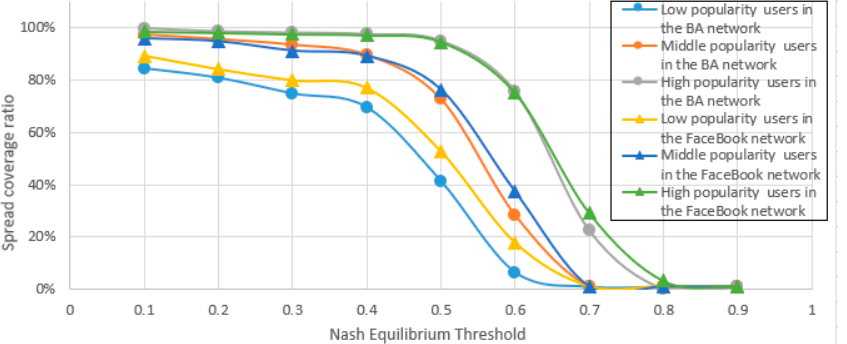
Figure 9. Range of privacy dissemination under different Nash equilibrium thresholds in the BA and the Facebook networks.